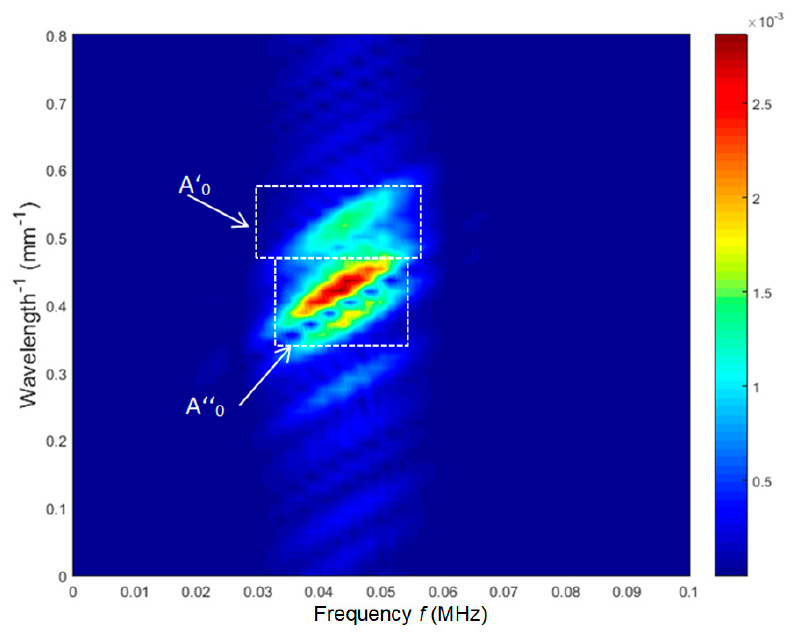
Figure 18. 2D spatial-temporal spectrum of the B-scan mode in the case of a multiple circular non-uniformities ( t = 20:400 μ s, y = 3 mm) .